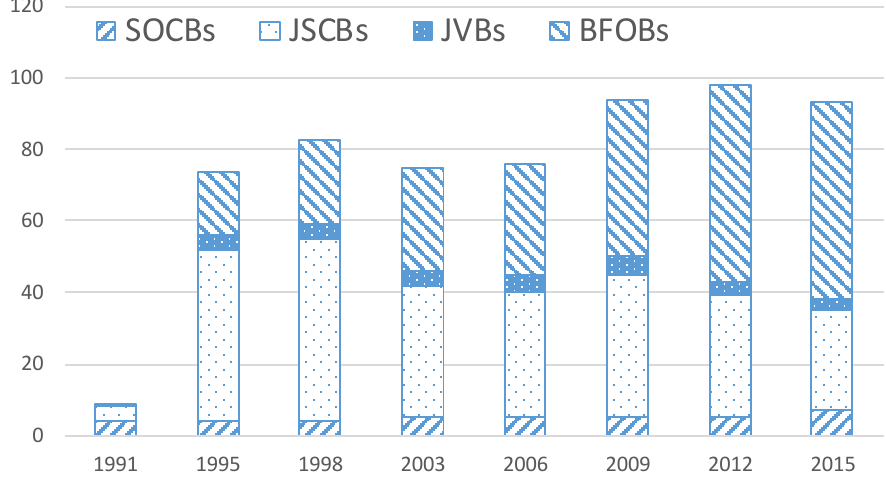
Figure 1. Number of Vietnamese banks over time. Notes: SOCBs: State-Owned Commercial Banks; JSCBs: Joint Stock Commercial Banks; JVBs: Joint Venture Banks; BFOBs: Branches of Foreign-Owned Banks (also include Fully Owned Foreign Banks after 2007). Source : SBV .